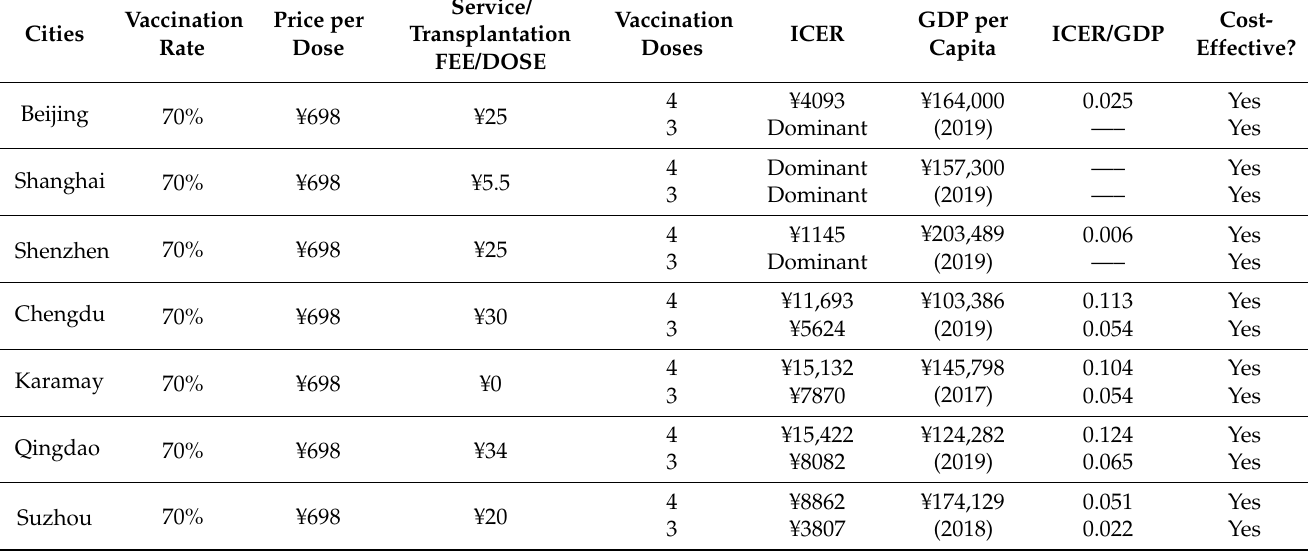
Table 4. Base Case Results—Analysis of Dosing